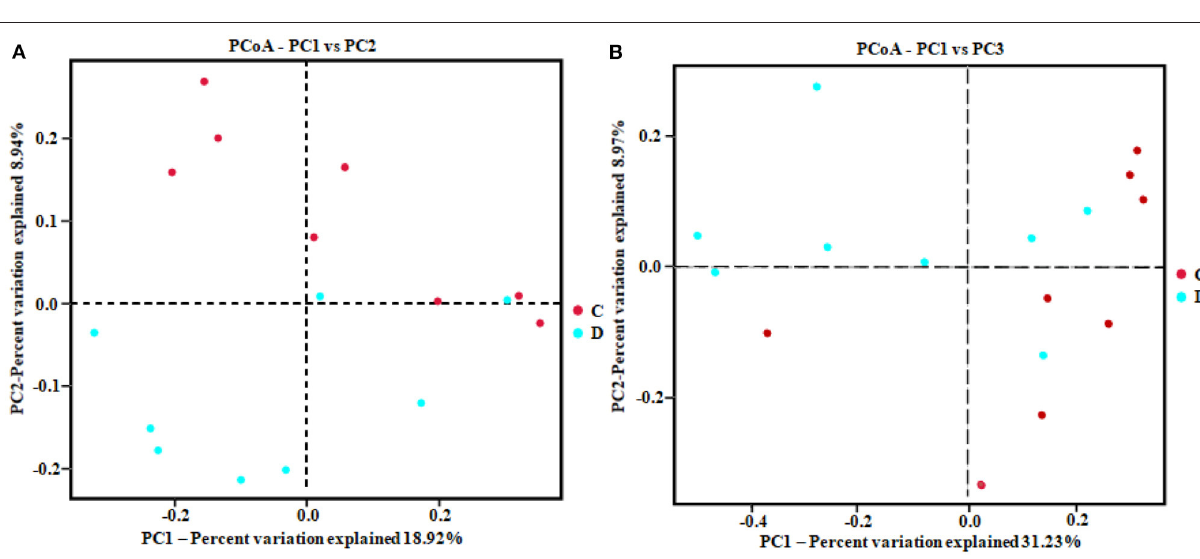
associated with Triangularia (0.8794), Sebacina